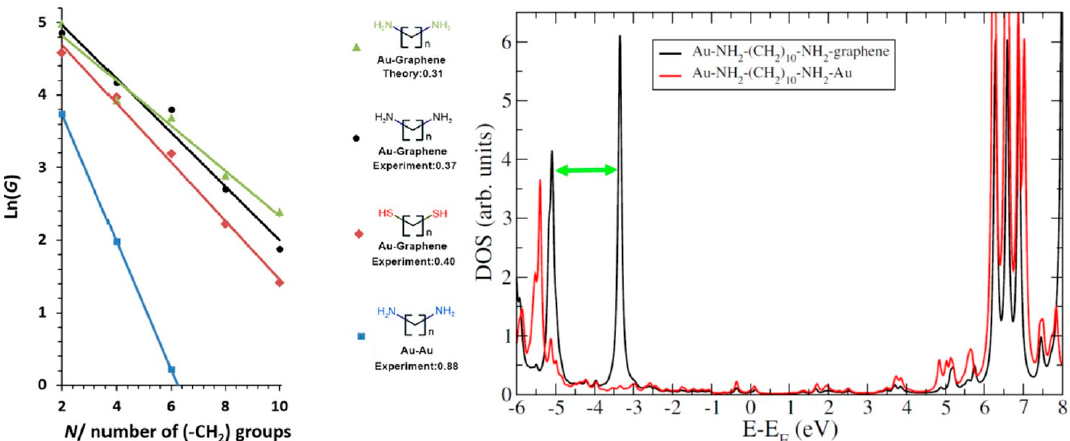
Figure 5. ( Left ) Evolution of the conductance as a function of the molecular length for molecular junctions with different anchoring groups and electrodes: conductance calculation on Au–graphene junctions with amine group (green), conductance measurements on Au–graphene junctions with amine group (black), conductance measurements on Au–graphene junctions with thiol group (red) and conductance measurements on Au–Au junctions with amine group (blue). ( Right ) Density functional theory (DFT) calculated density of states (DOS) for Au–graphene and Au–Au molecular junctions with amine anchoring groups. Reprinted figure from [46] and with permission. Copyright (2017) American Chemical Society.